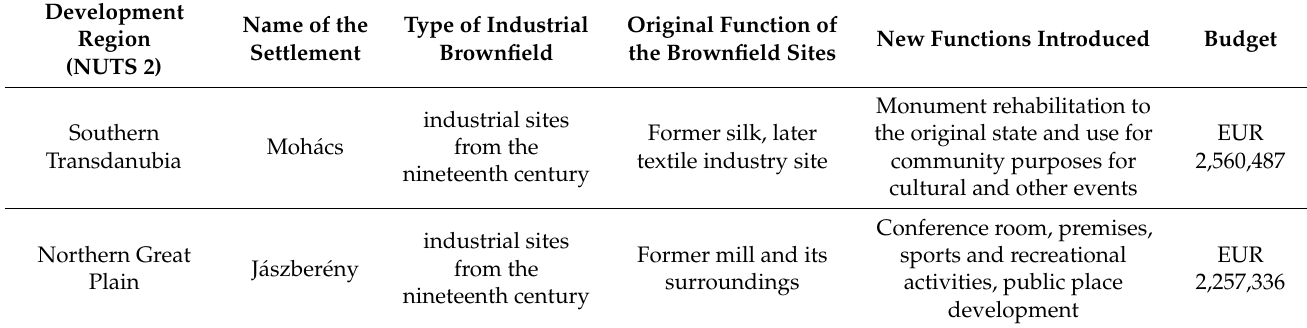
Table 5. Redevelopment projects for industrial brownfields and waterfront brownfields.